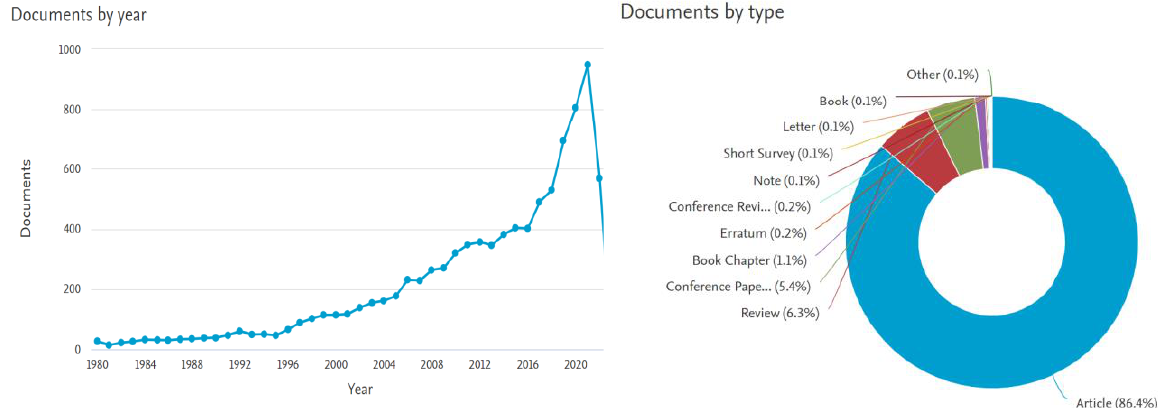
Figure 1. The number of articles per year and their distribution per type, SCOPUS cited on 27.08.2022